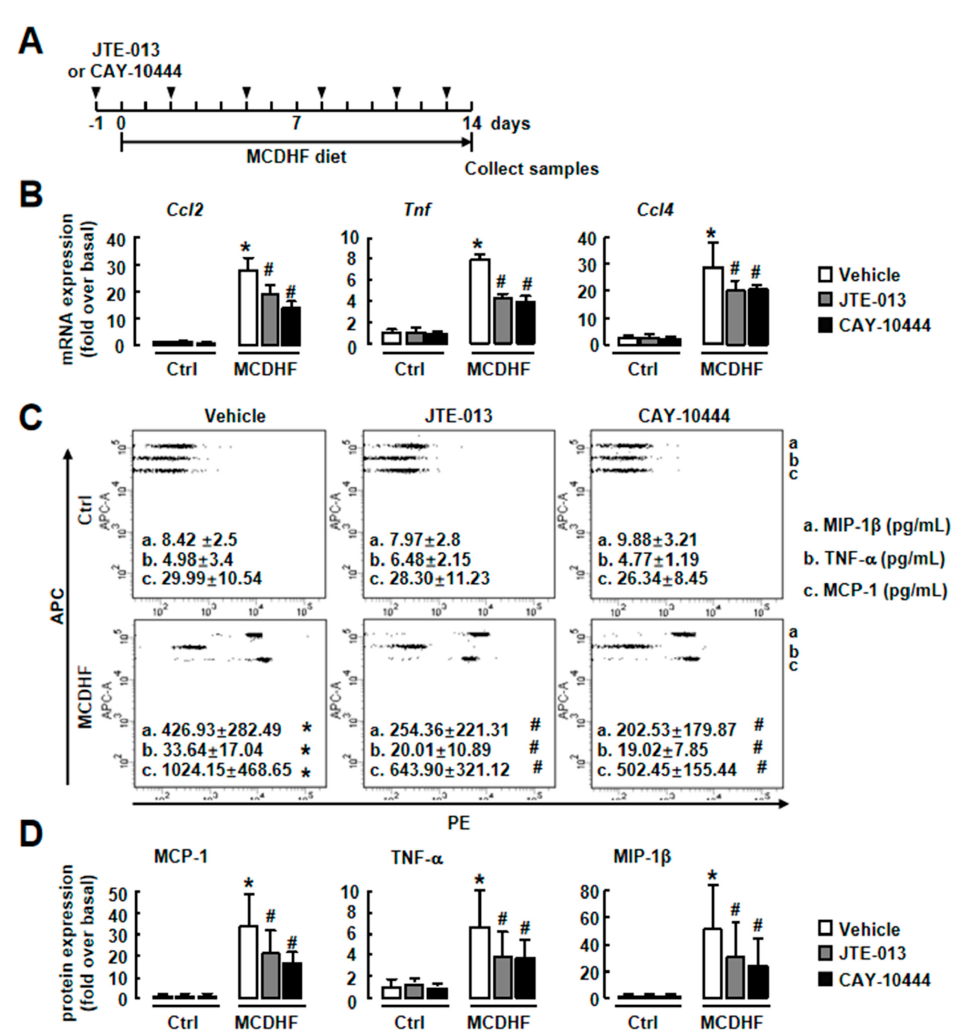
Figure 3. S1PR 2 / 3 blockade decreased hepatic inflammation in the MCDHF-diet-fed mice. ( A ) Scheme of the mouse model. ( B ) The mRNA expressions of pro-inflammatory factors in the liver from vehicle and JTE-013- and CAY-10444-treated mice after 14 days of control or MCDHF diet feeding. ( C ) The hepatic protein expressions of pro-inflammatory factors were detected by CBA. The representative flow cytometric images are shown. The signals of the APC channel, which was formed by specific antibody-coated beads of different fluorescence intensity, showed different pro-inflammatory factors as marked. The signals of the PE channel showed the levels of pro-inflammatory factors in each sample. ( D ) Quantification of CBA. The concentrations of pro-inflammatory factors were calculated and compared with the control group. Data are presented as the mean ± SEM. * p < 0.05 versus the control group. # p < 0.05 versus MCDHF diet group ( n = 6 for each group in each experiment).